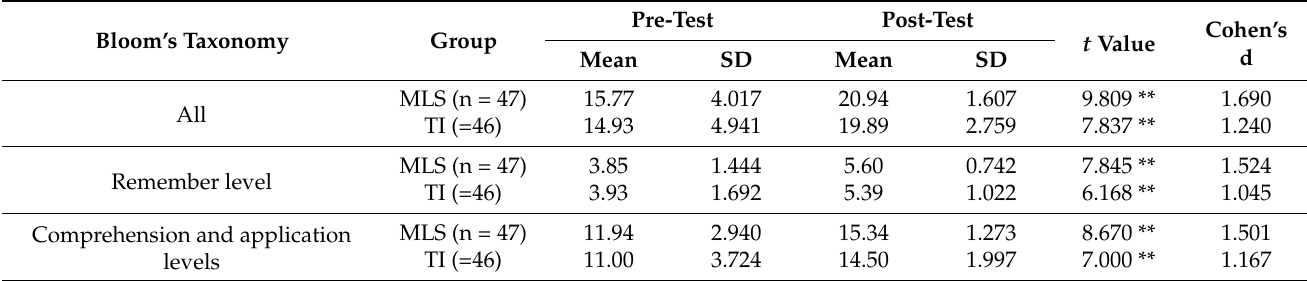
Table 5. Descriptive statistics of the pretest and posttest scores of mathematics learning achievement